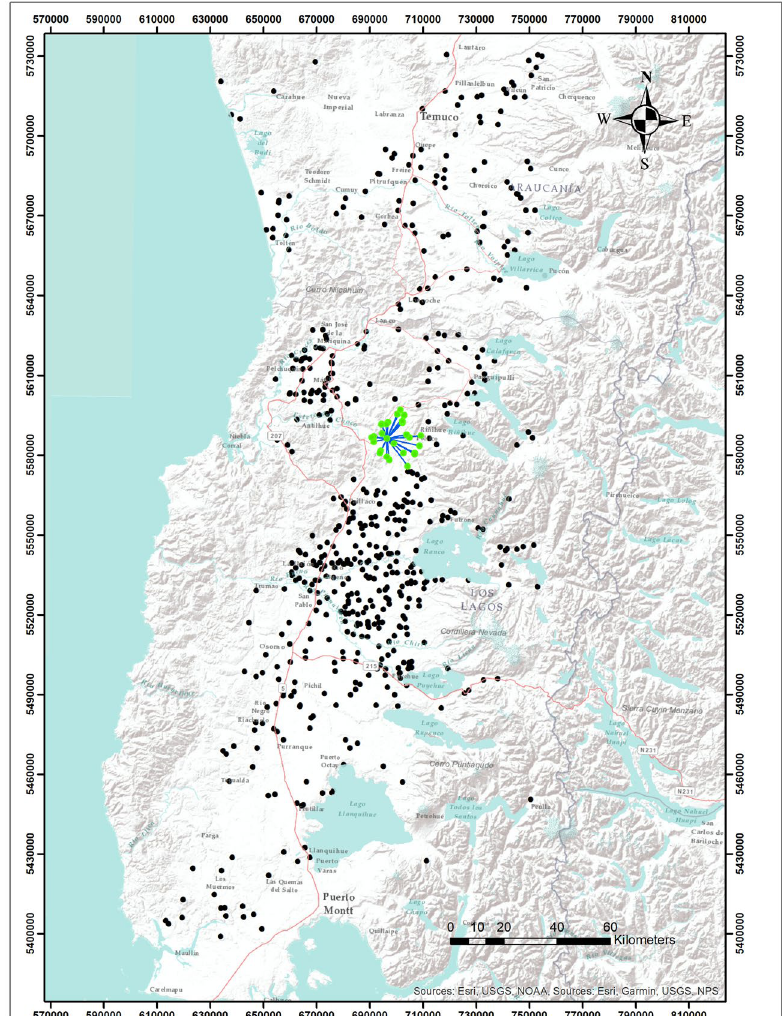
Fig. 11 Location of the configurations of the best combination found, with 50% biomass availability scenario, transport cost of 0.4 USD/tkm and energy price of 100 USD/